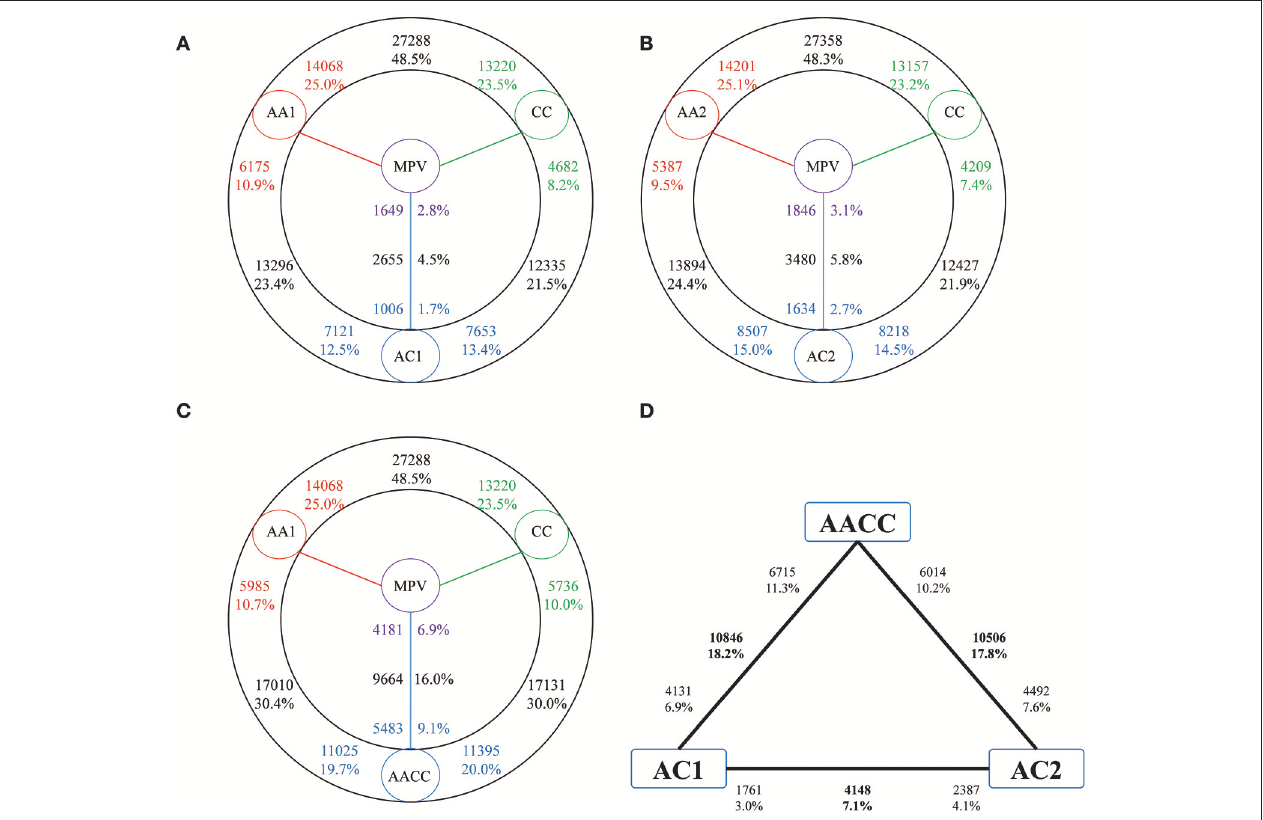
FIGURE 2 | Differential gene expressions among hybrids and their progenitors. The total number of genes (black) differentially expressed is given in each contrast. Number close to the species (colored) represent up-regulated compared with the adjacent species. These percentages are calculated by dividing the total number of expressed genes in two adjacent species. Red, A genome progenitor; green, C genome progenitor; blue, hybrids; purple, MPV. (A) Hybrid AC1. (B) Hybrid AC2. (C) Natural B. napus AACC. (D) Cross comparisons between two hybrids and natural B. napus